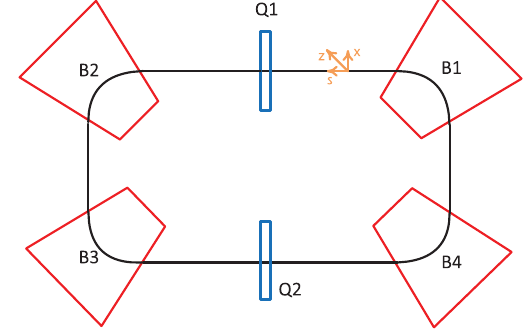
FIG. 1. Schematic of the example ring. The lattice consists of 4 dipoles (indices from B1 to B4) and 2 quadrupoles (Q1 and Q2). The Frenet-Serret coordinate system is represented by ð x ; z ; s